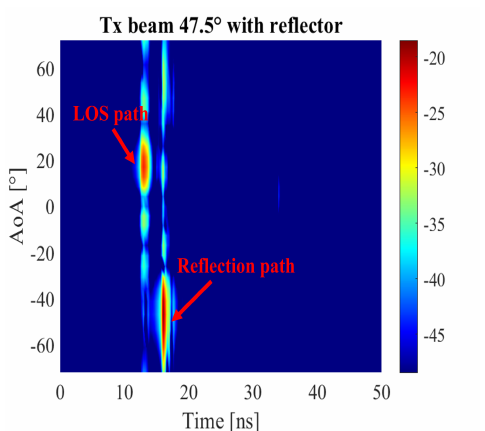
Figure 16. PADP of channel with Tx beam-steering at 47.5° and with the